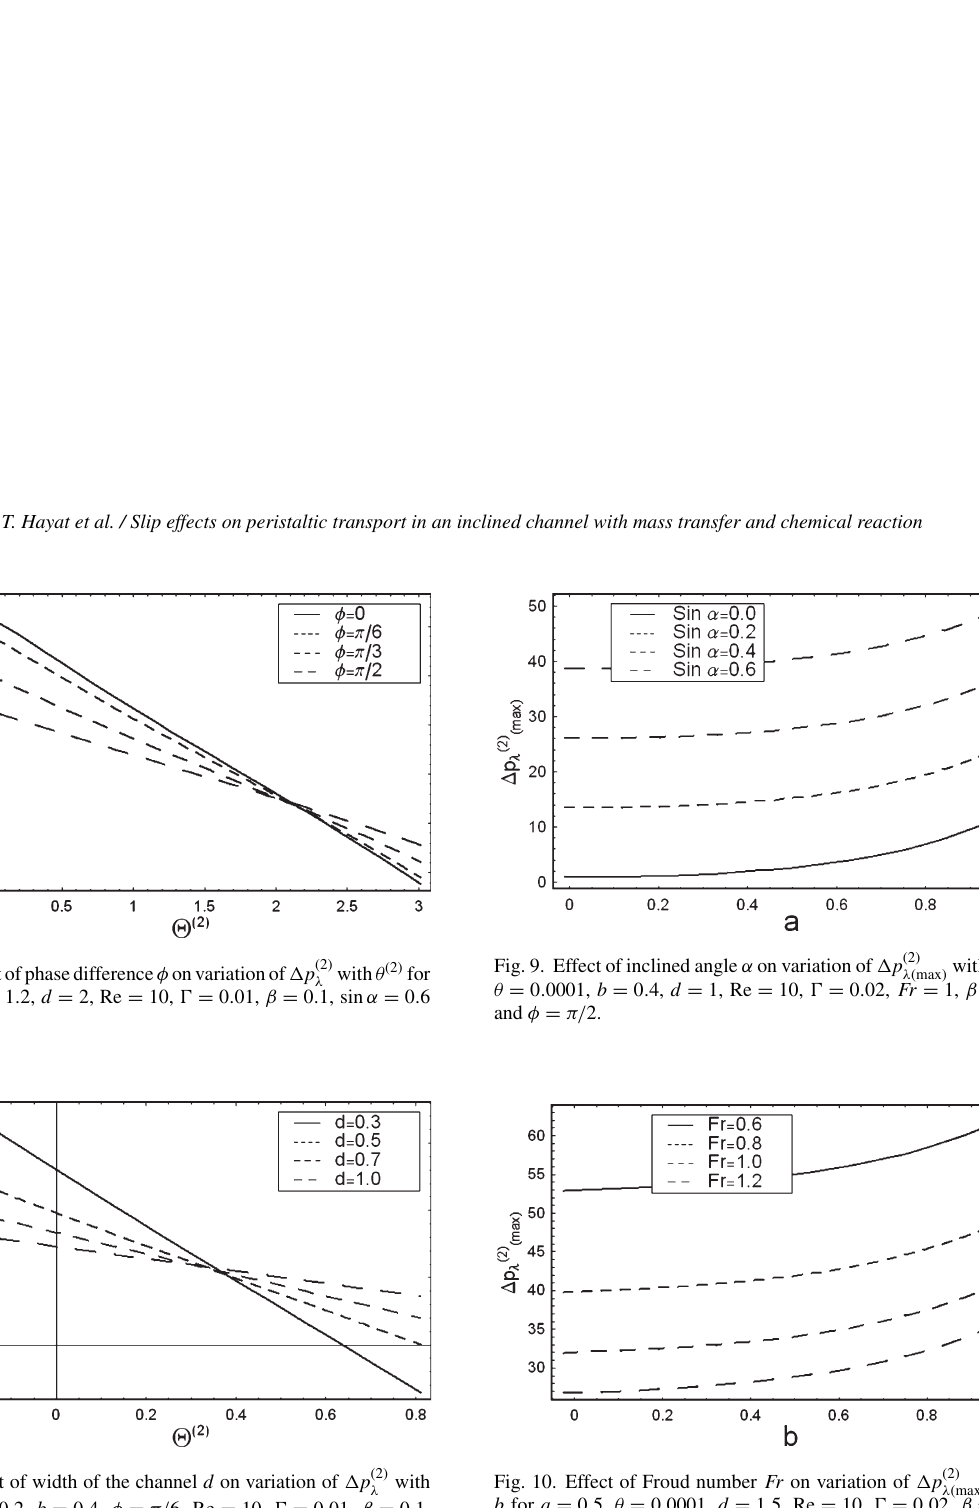
Fig. 7. Effect of width of the channel d on variation of (cid:16)p (2) θ (2) for a = 0 . 2, b = 0 . 4, φ = π/ 6, Re = 10, (cid:15) = 0 . 01, β = 0 . 1, sin α = 0 . 2 and Fr = 1.